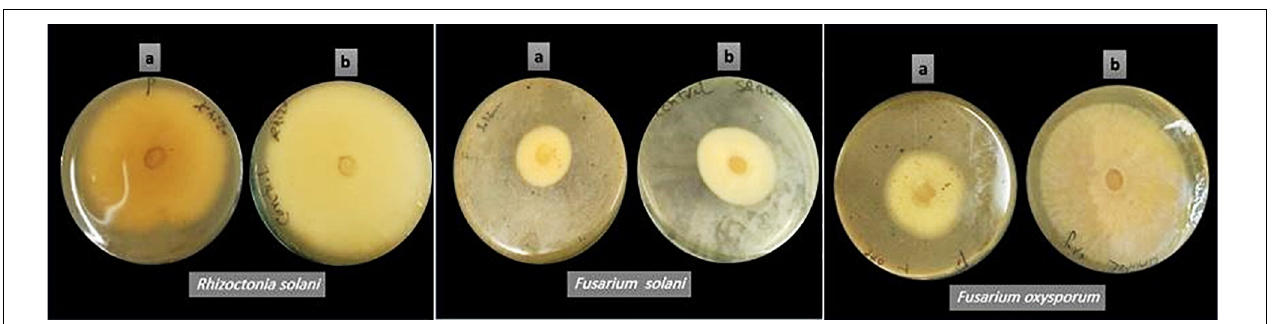
Polar extract of P. ostreatus